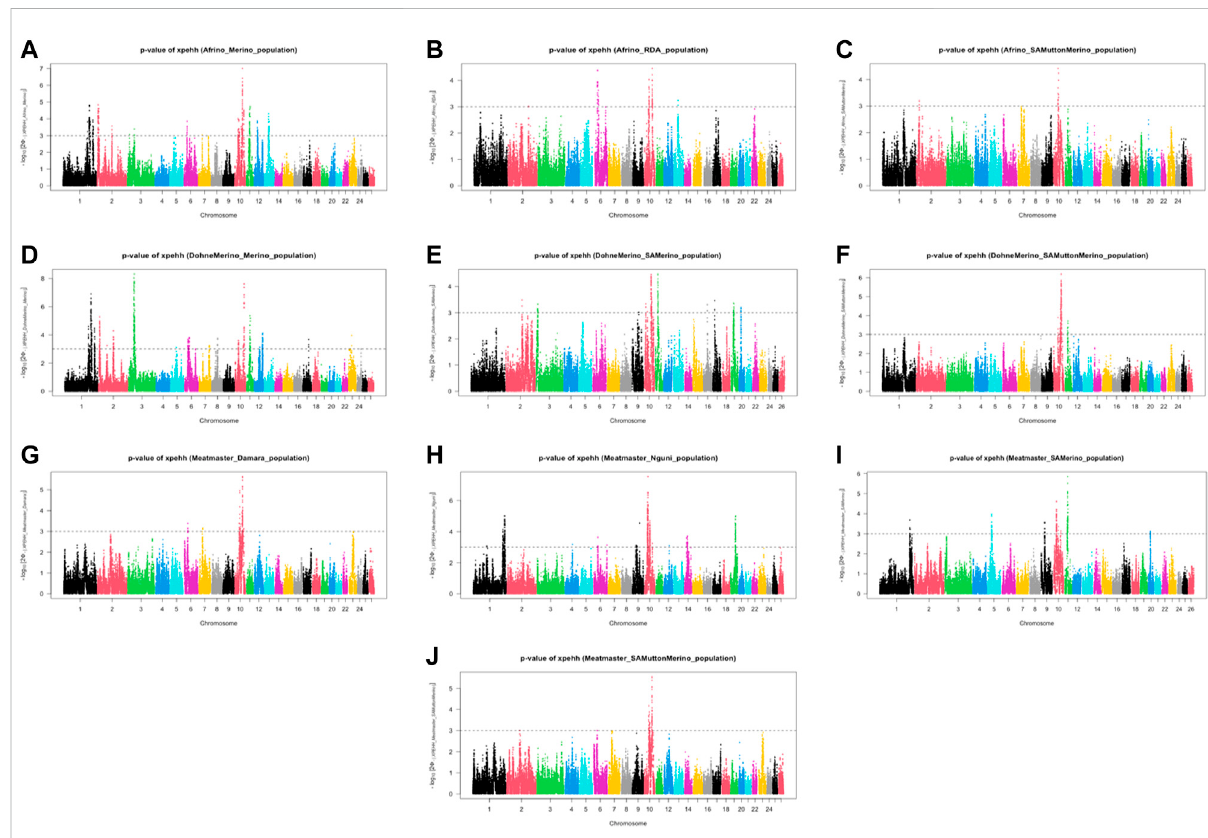
FIGURE 5 XP-EHH scores of Merino-derived breeds against presumed ancestors. Genome-wide XPGenome-wide XP-EHH scores of Merino-derived breeds and against ancestors. Afrino and Merino (A) , Afrino and RDA (B) , Afrino and (C) , Dohne Merino and Merino (D) , Dohne Merino and SAMerino Dohne Merino and SAMuttonMerino (F) , Meatmaster and Damara Meatmaster and Nguni (H) , Meatmaster and SAMerino (I) and Meatmaster and SAMuttonMerino (J) .